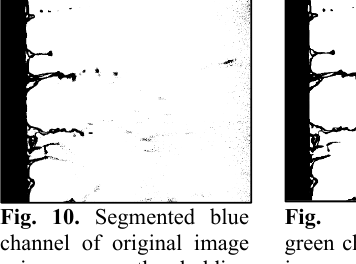
Fig. 10. Segmented blue channel of original image using thresholding (threshold = 0,74).